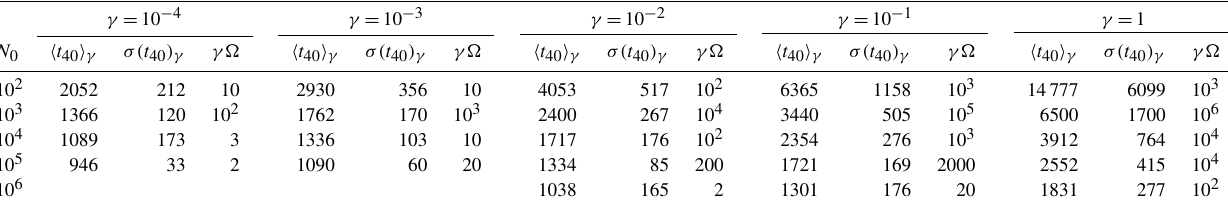
Table 1. Average and standard deviation of time (in s) for lucky realizations to produce a single drop with r ≥ 40µm. γ is fraction of the fastest realizations out of all (cid:127) realizations that were used to compute the respective (cid:104) t 40 (cid:105) γ and σ(t 40 ) γ . The sub-ensemble size γ(cid:127) is shown to give an idea about precision of estimation of the respective statistics.